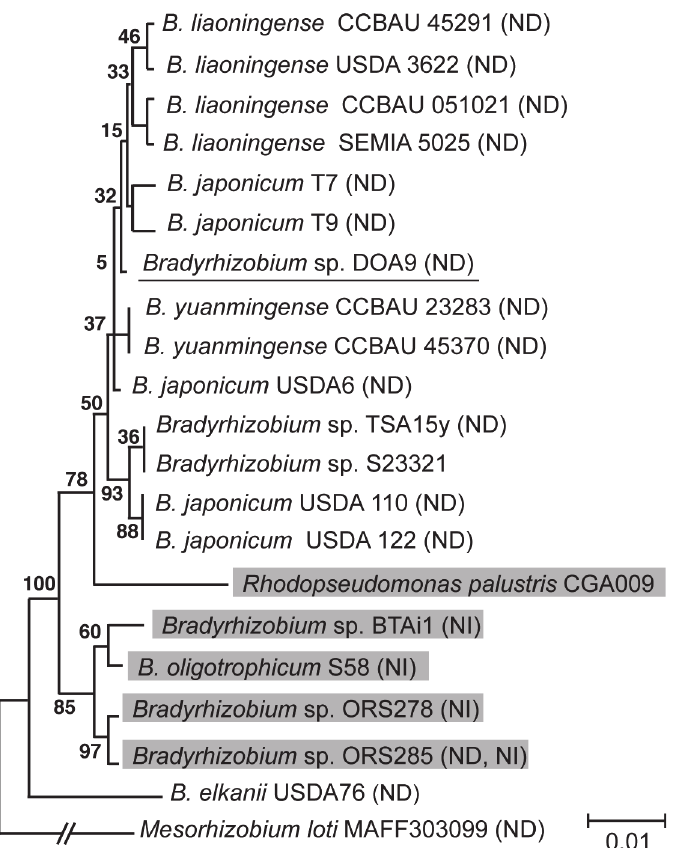
Fig 1. Phylogenetic relationships of Bradyrhizobium sp. DOA9 and related bacteria based on 16S rRNA gene sequences. Bootstrap values are expressed as percentages of 1,000 replications. Evolutionary distances were computed using the Kimura two-parameter method. The bar represents one estimated substitution per 100-nucleotide positions. Strains capable of Nod factor-dependent and -independent nodulation are marked with (ND) and (NI), respectively. Photosynthetic strains are highlighted in gray.